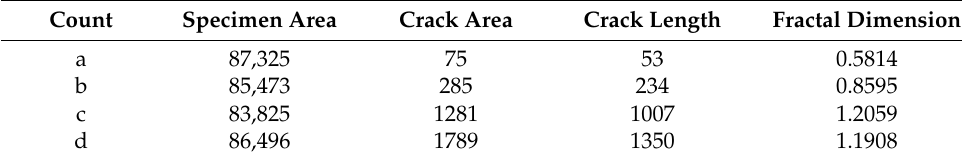
Table 3. Extraction Results of